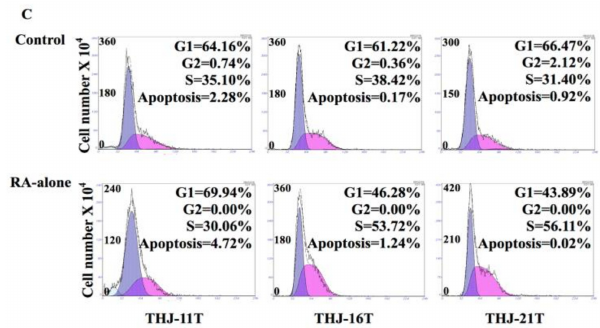
Figure 1. Lack of response of the three anaplastic thyroid cancer (ATC) cell lines to 10 µ M retinoic acid (RA) treatment. ( A ) H/E staining ( × 40) and Cyclin D1 immunocytochemical staining (insets; × 40); ( B ) 3-[4,5-Dimethylthiazol-2-yl]-2,5-diphenyl-tetrazolium bromide (MTT) cell proliferation assay; ( C ) flow cytometry. Control, without resveratrol treatment; RA-alone, 10 µ M retinoic acid treatment. NS, without statistical significance ( p > 0.05); the error bars, the mean ± standard deviation; , apoptosis peak; , G1 phase; , S phase; , G2 phase.